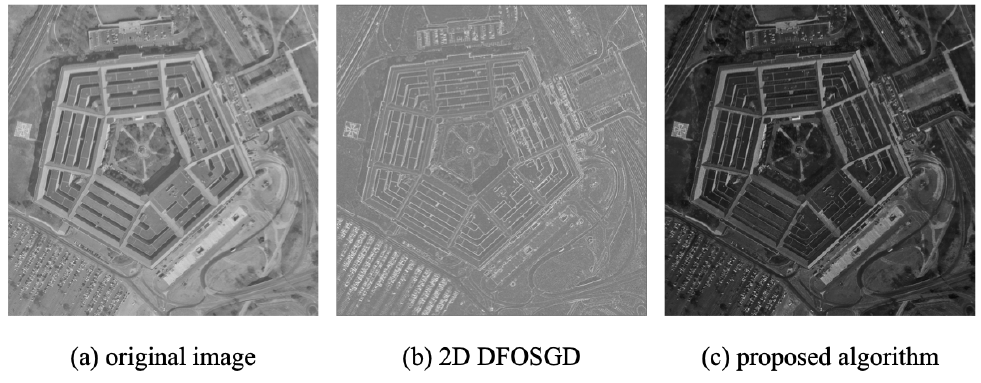
Figure 15. Enhancement results of image